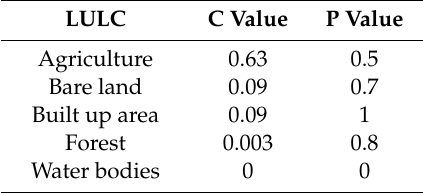
Table 3. C and P values for di ff erent land use land cover.